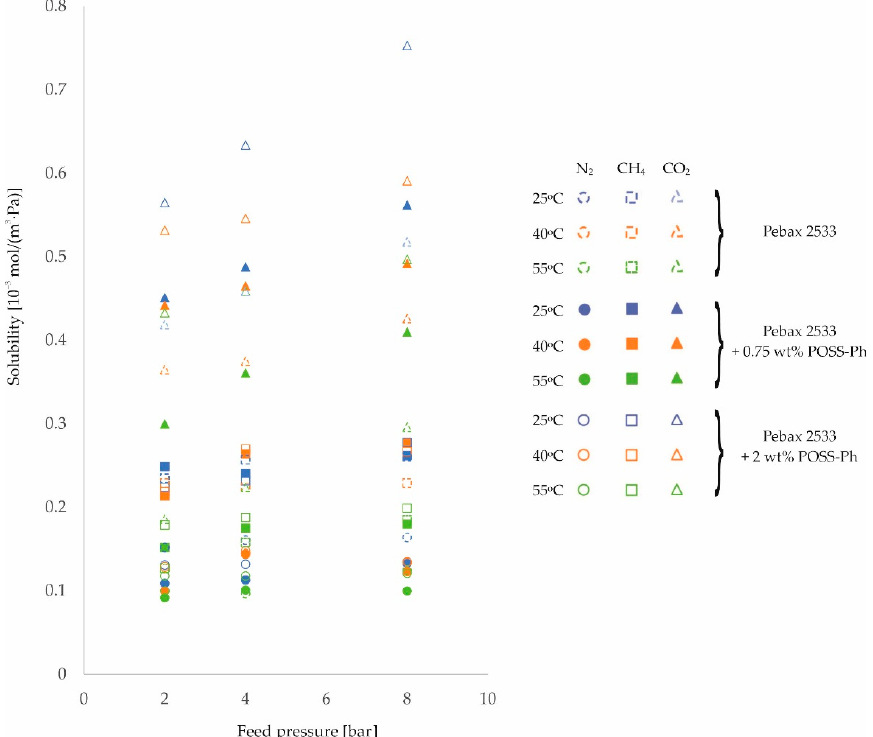
Figure 9. Change in solubility coefficient values of homogeneous membrane and heterogeneous membranes containing POSS ‐ Ph for different feed pressure and temperature